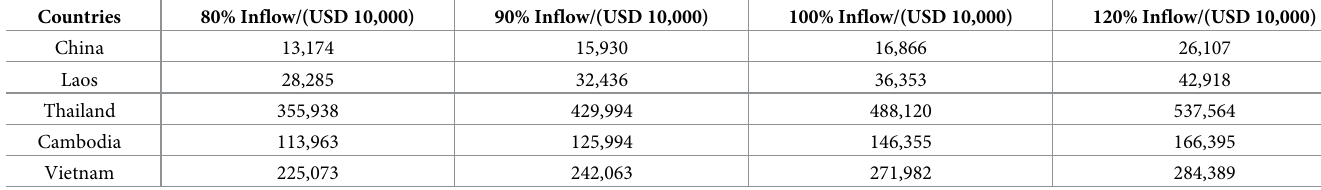
Table 13. Each state’s benefits under the cooperation of the five countries.